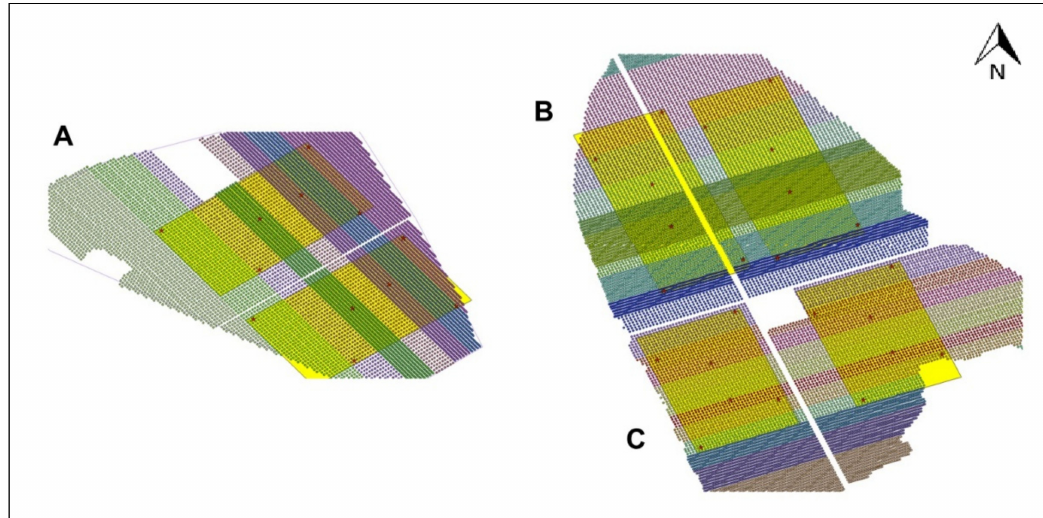
Figure 1. Graphic representation of the multi-varietal orchards Verbesi New (on the left) and Verbesi Old (on the right) in the farm Azienda Verbesi (Rome, Italy), which were used to test the medfly Decision Support System (DSS). The experimental scheme in blocks A, B, and C is shown. The yellow rectangles delimit the plots in each block and the red stars indicate the position of the monitoring traps (e-traps in the DSS-assisted plots; Jackson traps in the conventional plots) in the field. The variously coloured dots identify the position of the trees and the extent of the cultivars (see Table S1 for